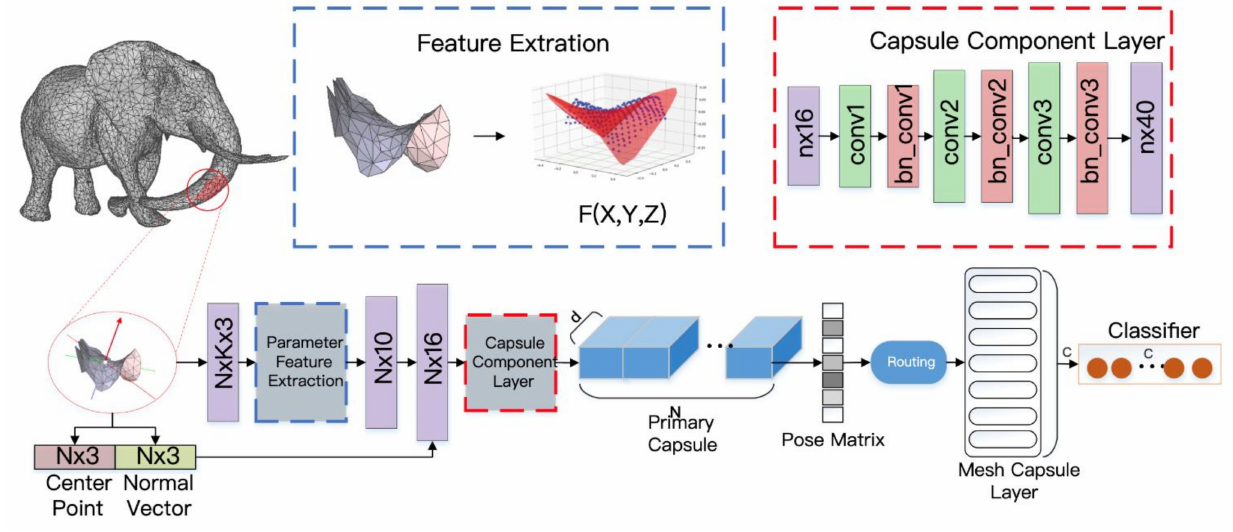
Figure 3. Network